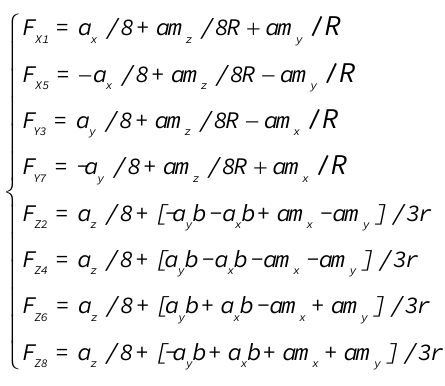
Figure 2. Block diagram of the sensor’s